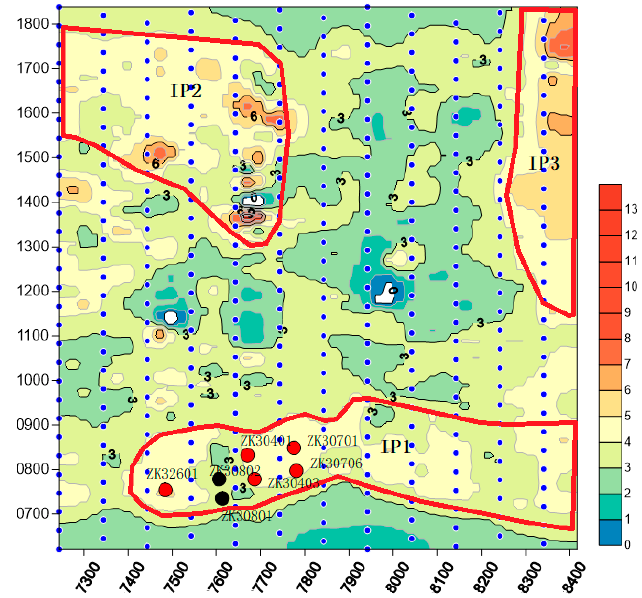
Figure 7. The SPDE prediction contour map of induced polarization data. The red and black symbols are the logging well with and without gold mine, respectively.